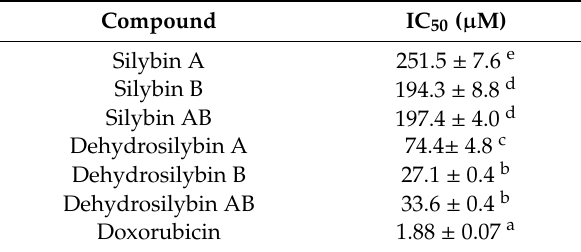
Table 7. The impact of silybin and dehydrosilybin stereomers on the viability of doxorubicin-resistant human ovarian adenocarcinoma cell